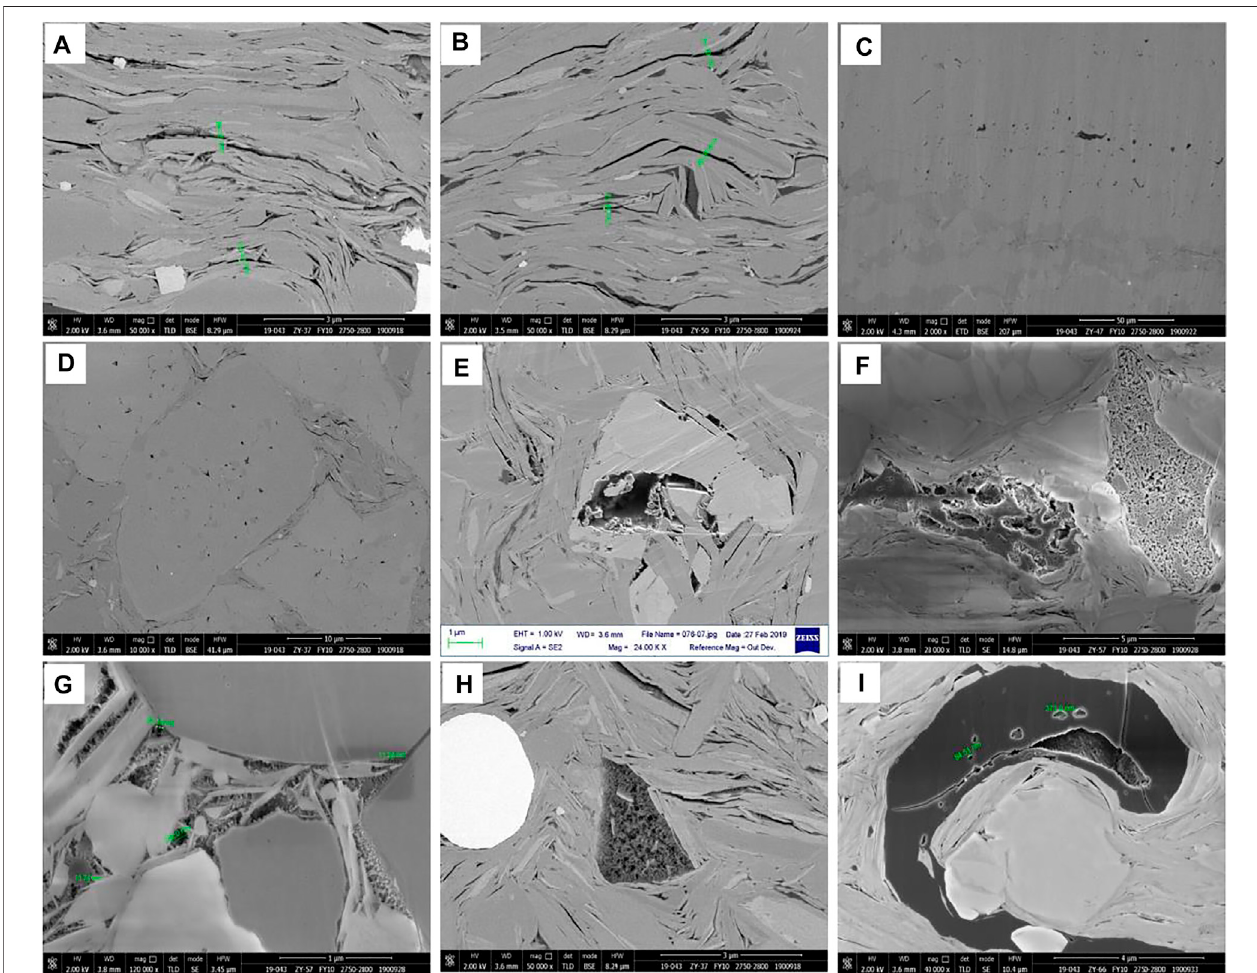
FIGURE 6 | Pore morphology from SEM of Dongyuemiao shale (A) linear pores between clay minerals, 2,782.04 m; (B) linear pores between clay minerals, 2,790.79 m; (C) calcite dissolved pores, 2,788.87 m; (D) calcite dissolved pores, 2,782.04 m; (E) calcite dissolved pores, 2,802.37 m; (F) organic pores, 2,794.41 m; (G) Organic pores, 2,794.41 m; (H) organic pores, 2,782.04 m; (I) organic pores, 2,797.81 m.